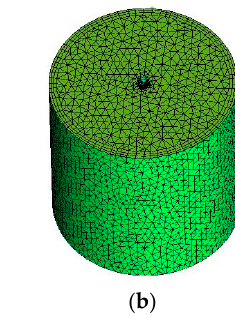
Figure 2. Meshing of the computational domain with tetrahedral elements: ( a ) Horizontal view; ( b ) Isometric